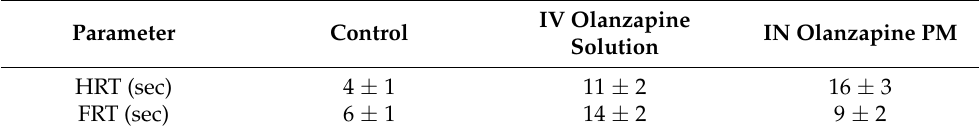
Table 4. The pharmacodynamic assessment of IV olanzapine solution and IN olanzapine PM on normal